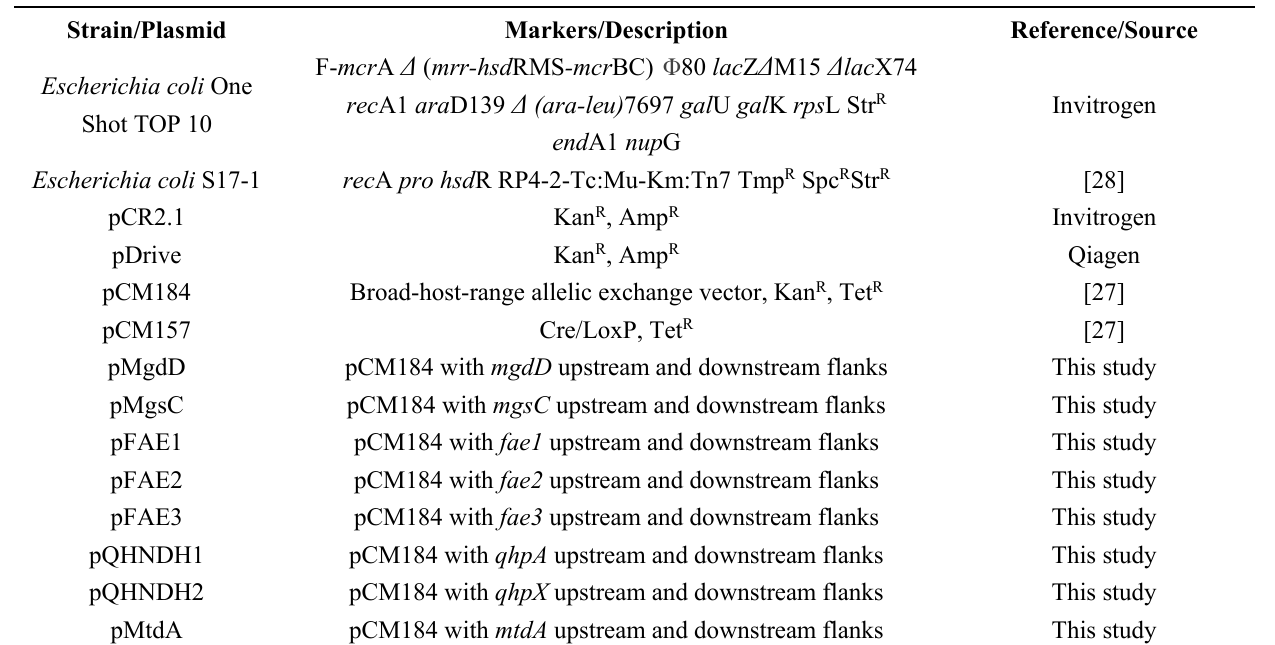
Table 2. Bacterial strains and plasmids used in this